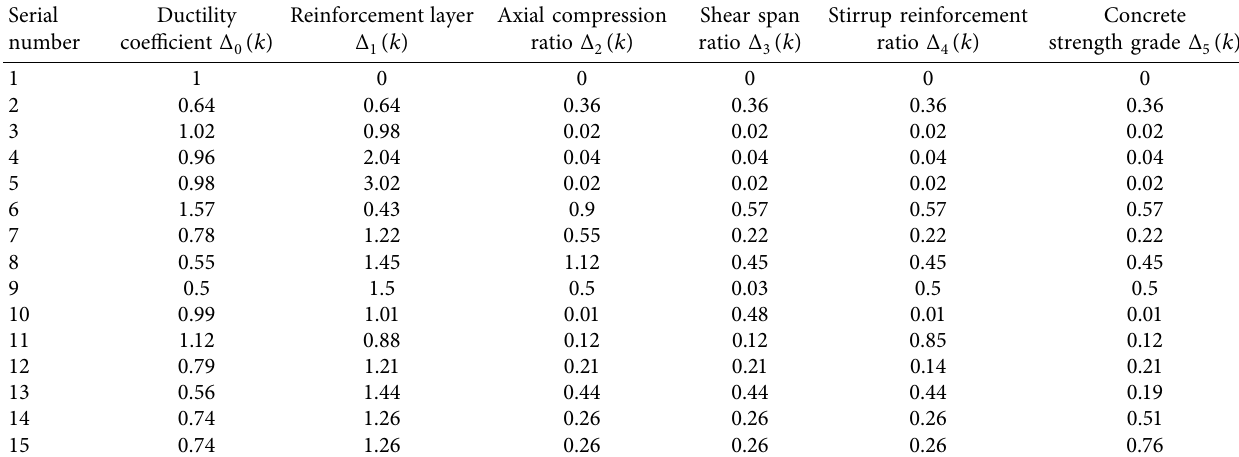
Table 3: Absolute difference of the specimens.